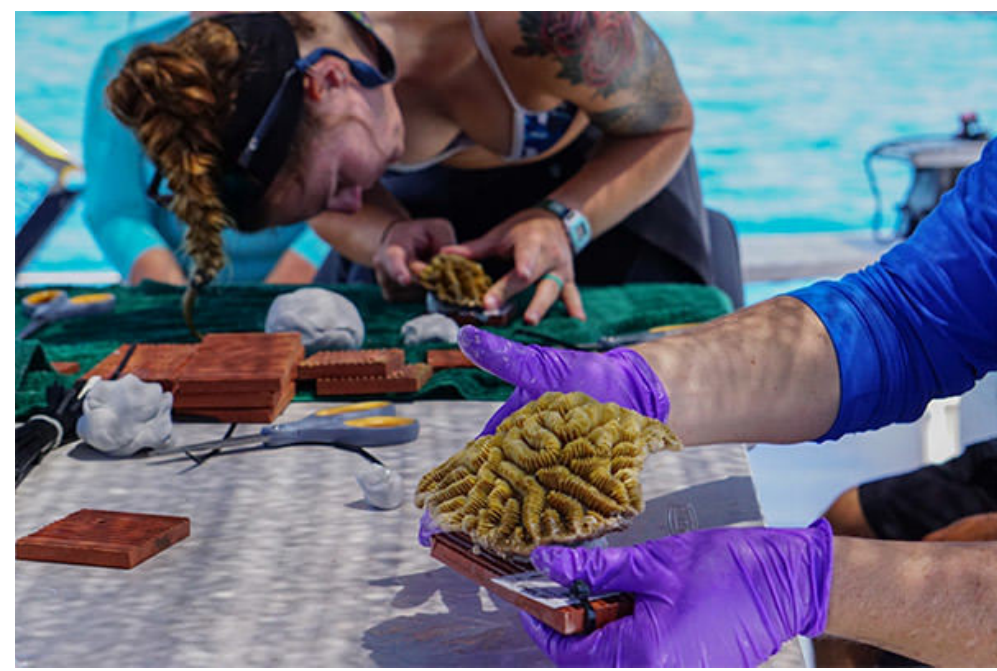
Figure 4: The description reads, “A Montastraea cavernosa is mounted and receiving its tag before being placed into the holding bin onboard the Makai.” Photo by Jennifer Moore/NOAA, taken on May 19, 2019. Source: FWC Fish and Wildlife Research Flickr Account. NonCommercial-NoDerivs 2.0 Generic (CC BY-NC-ND